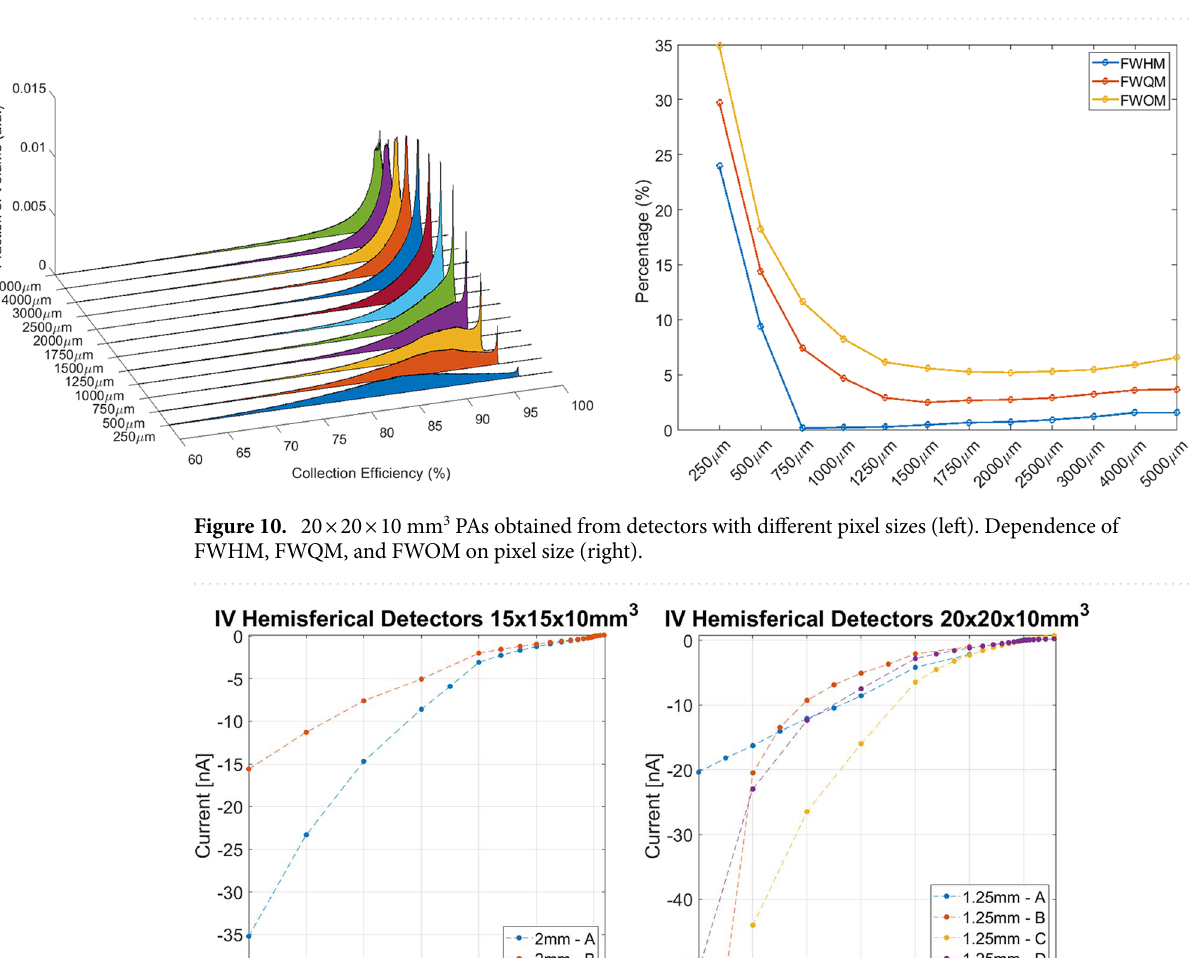
Figure 9. 15 × 15 × 10 mm 3 PAs obtained from detectors with different pixel sizes (left). Dependence of FWHM, FWQM, and FWOM on pixel size (right).